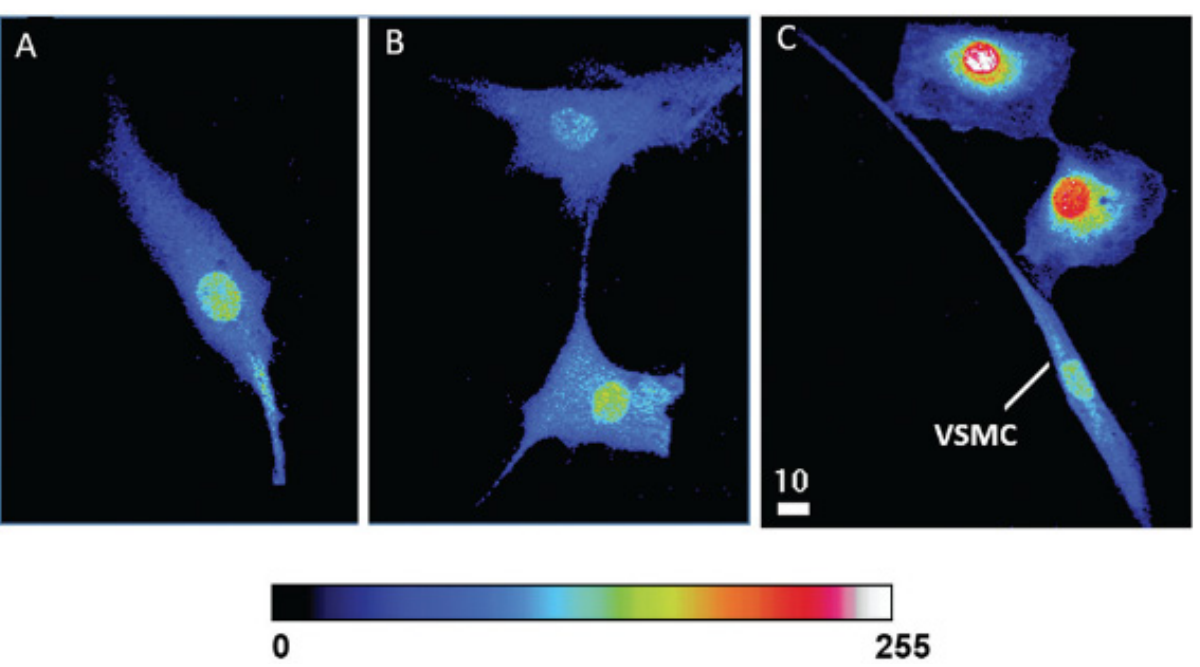
Figure 5. Modulation of cytosolic and nuclear calcium levels of human VSMCs by physical contact with human VECs. Quantitative 3D confocal microscopy images showing the distribution of cyto- solic and nuclear Ca 2+ in hVSMCs in pure culture of hVSMCs without contact ( A ) and in contact with other hVSMCs ( B ), as well as in co-culture with hVECs ( C ). The pseudo-color scale represents the level of fluorescence intensity of the Fluo-3–Ca 2+ complex from 0 (black, absence of fluorescence) to 255 (white, maximum fluorescence) in panels A, B, and C. The white scale bar value is in micrometers (modified from Hassan et al., 2018) [105].